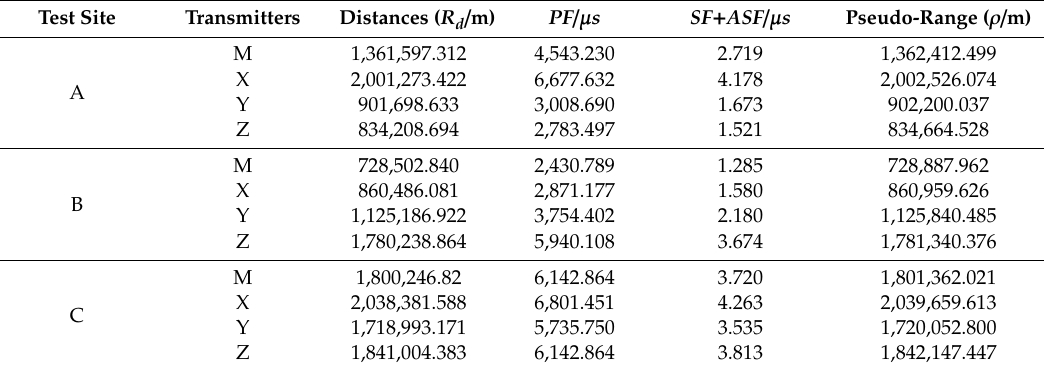
Table 3. Specification of simulation parameters, n s =